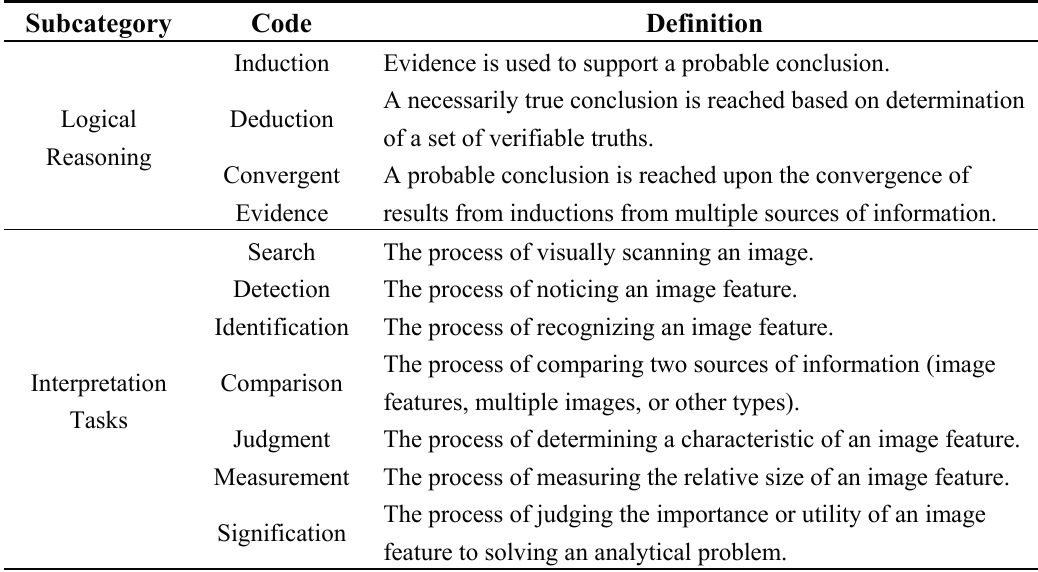
Table 3. Reasoning Skills codes used in this Content